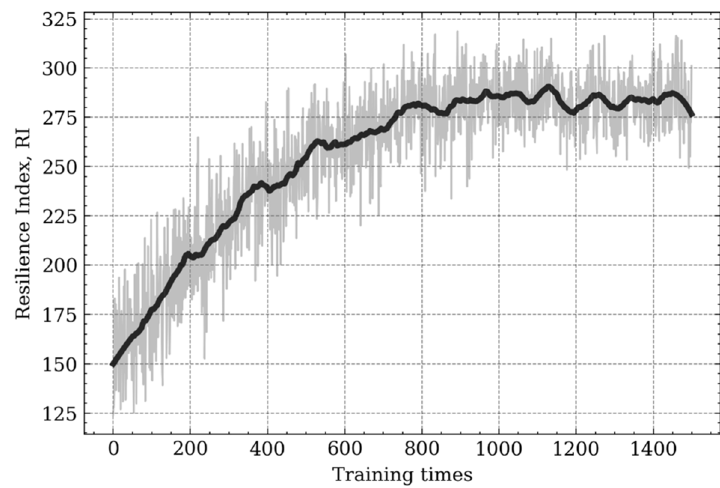
Fig. 7 The change of resilience index based on the repair decisions by the GCN-DRL model during the training